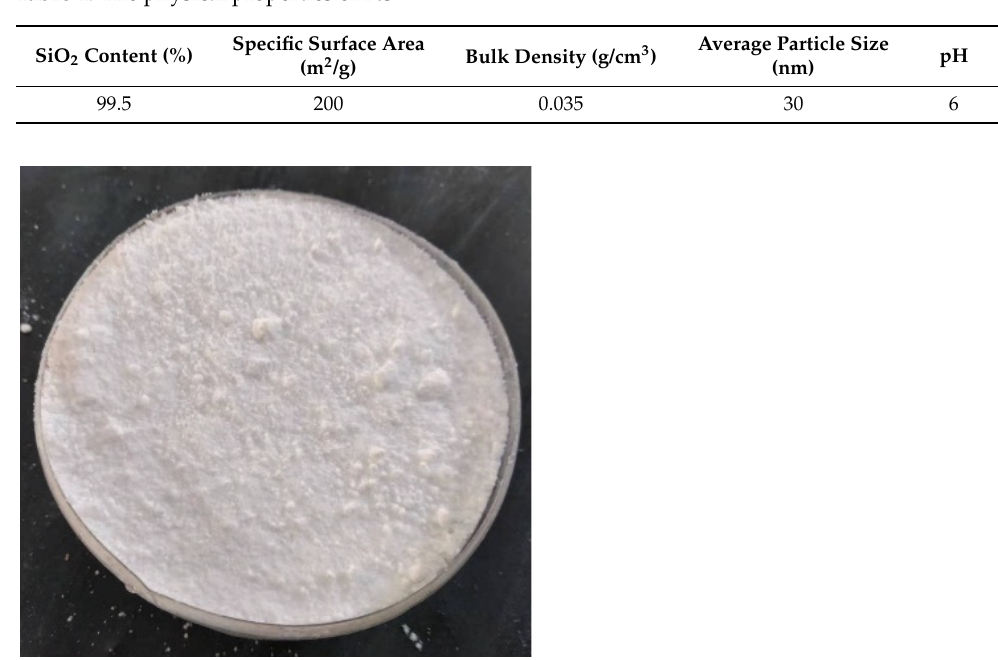
Figure 1. The appearance of powdery NS.